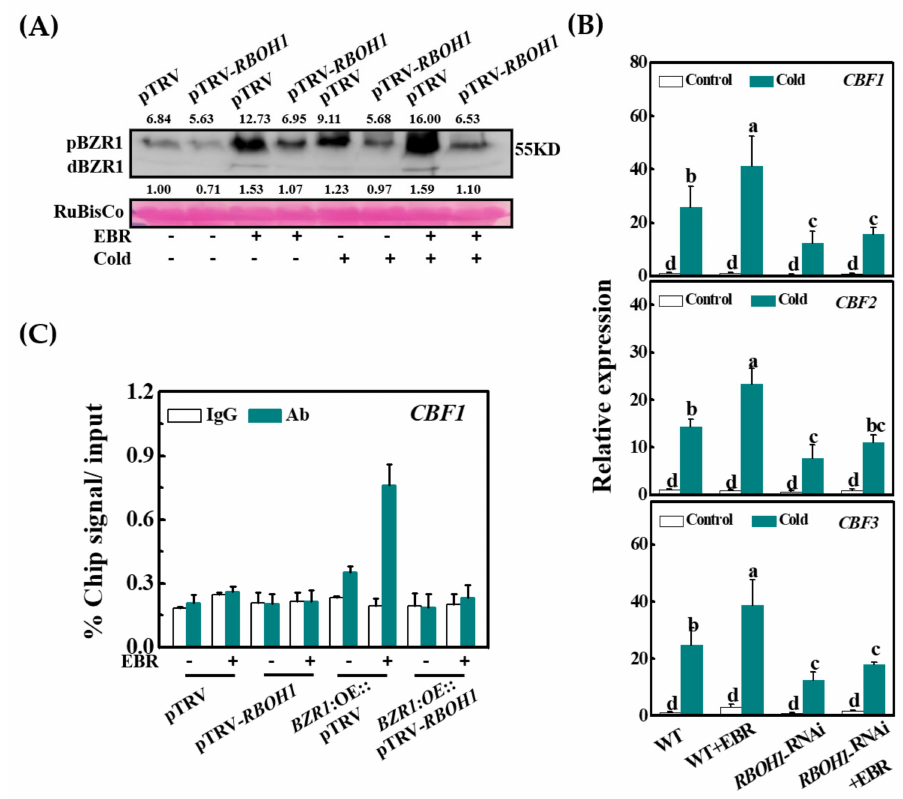
Figure 4. RBOH1 plays a role in BZR1 accumulation and counteracts BR-induced CBF expression. ( A ) The accumula- tion of BZR1 protein in the control (pTRV) and RBOH1 -silenced (pTRV- RBOH1 ) plants as influenced by the application of 24-epibrassinolide (EBR, 200 nM). Samples were collected after cold treatment at 8 ◦ C for 12 h, and 35S:BZR1 -3HA- overexpressing ( BZR1 :OE) plants were used for VIGS. The value above and below each lane indicates the relative accumula- tion of pBZR1 and dBZR1, respectively. ( B ) The relative expression levels of CBFs in wild-type (WT) and RBOH1 -RNAi plants. Plants were foliar applied with 200 nM EBR for 24 h and subsequently exposed to cold at 8 ◦ C for 8 h. ( C ) ChIP-qPCR analysis showing RBOH1 stimulation of DNA-binding activity of BZR1 in tomato. ChIP was performed with BZR1 :OE (pTRV or pTRV- RBOH1 ) plants foliar applied with 200 nM EBR for 12 h. CBF1 promoter fragments were immunoprecipitated with an anti-HA antibody. Mouse IgG was used in control reactions. Input- and ChIP-DNA samples were quantified by qRT-PCR. The ChIP data are shown as % input DNA. Data are the means of three biological replicates ( ± SD) shown by vertical error bars. Different letters indicate significant differences according to Tukey’s test at 0.05% level. VIGS, virus-induced gene